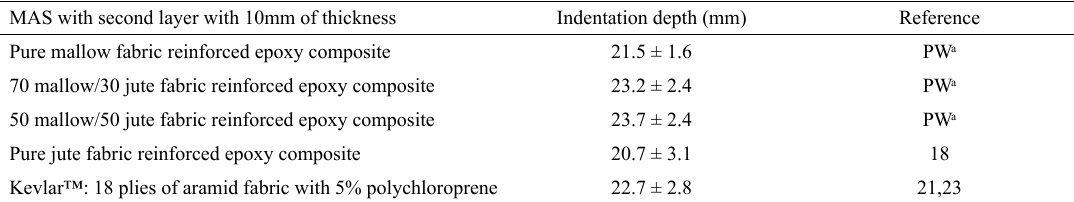
Table 1. Average depth of indentation depth in the clay witness after bullet impact in MASs with distinct natural fabrics. MAS with second layer with 10mm of thickness Indentation depth (mm) Reference